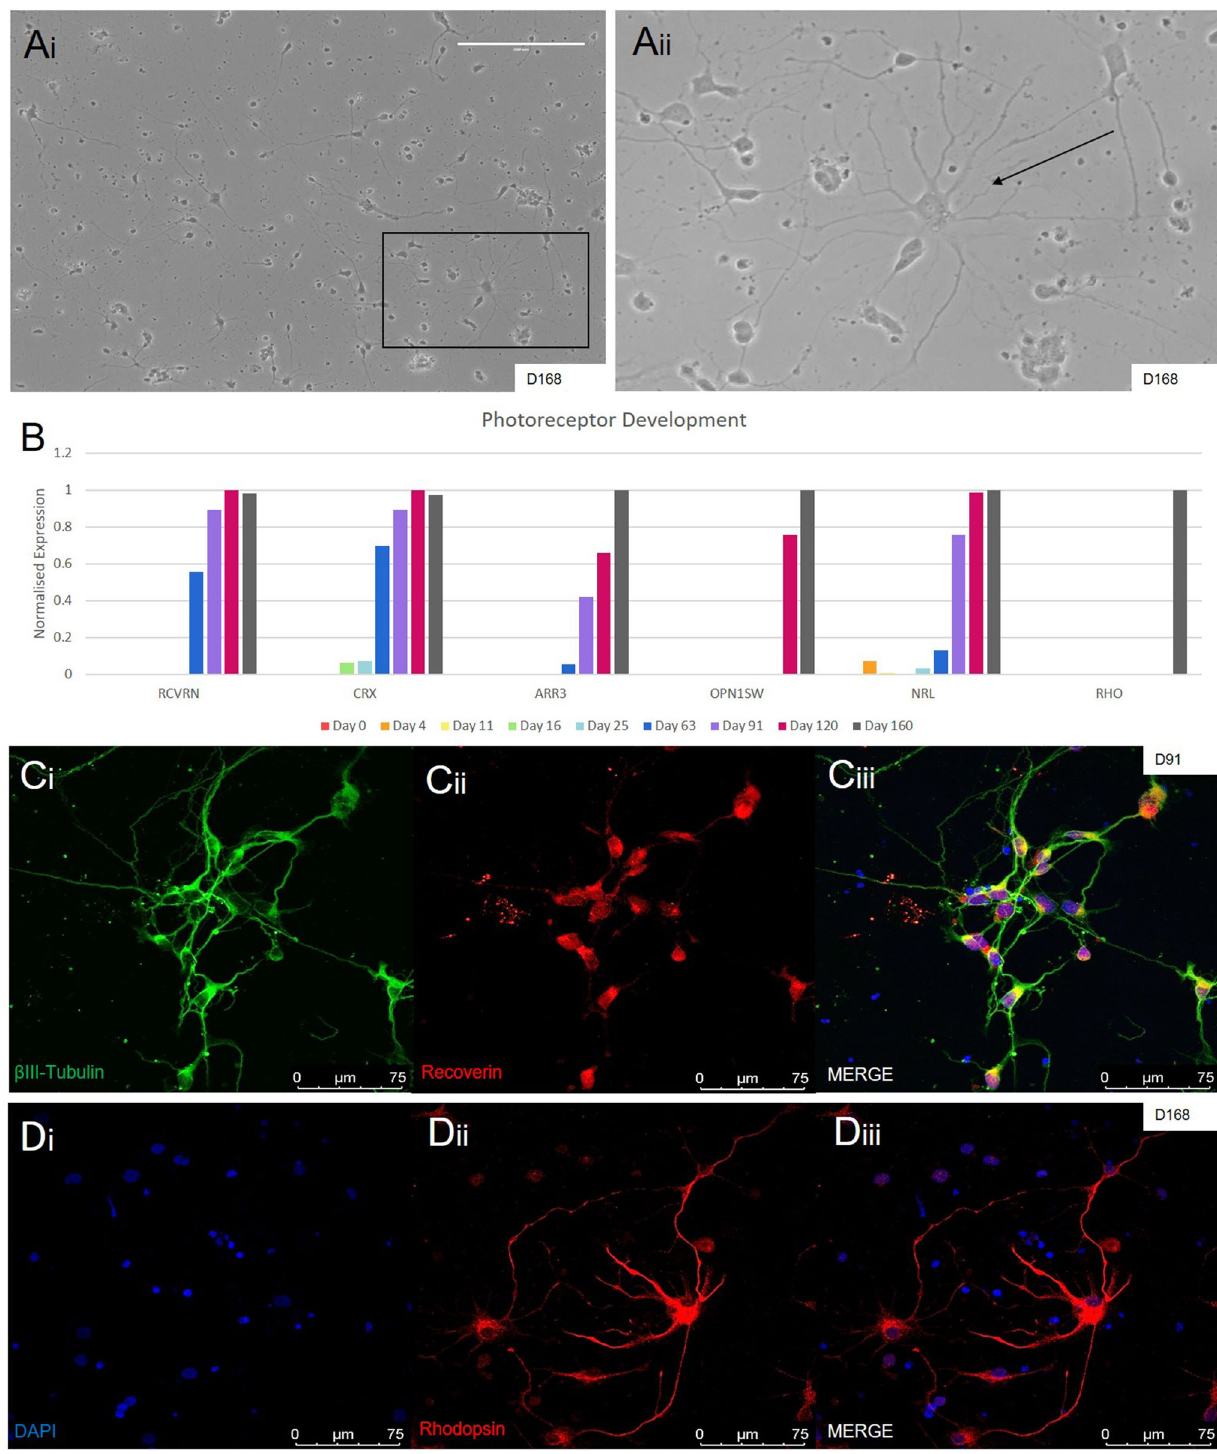
Figure 5. Generation of photoreceptors. ( Ai-ii ) Widefield images of plated photoreceptors at D168 (black arrow), obtained from dissociated organoids, show outgrowth that is morphologically different to plated ganglion cells (Shown in Fig. 6a) (Scale bar = 200 µm). ( B ) Quantitative RNA sequencing data of common photoreceptor progenitor markers CRX and RCVRN showed increasing expression after day 63, while the mature cone and rod markers ARR3, OPN1SW and NRL, RHO also increased over time, although not as dramatically. ( Ci-iii ) Expression of photoreceptor progenitor markers was seen with IHC staining of RCVRN (in red) with the general neuronal marker β-III Tubulin (in green). ( Di-iii ) More mature photoreceptors were stained using anti-rhodopsin antibody ROD (in